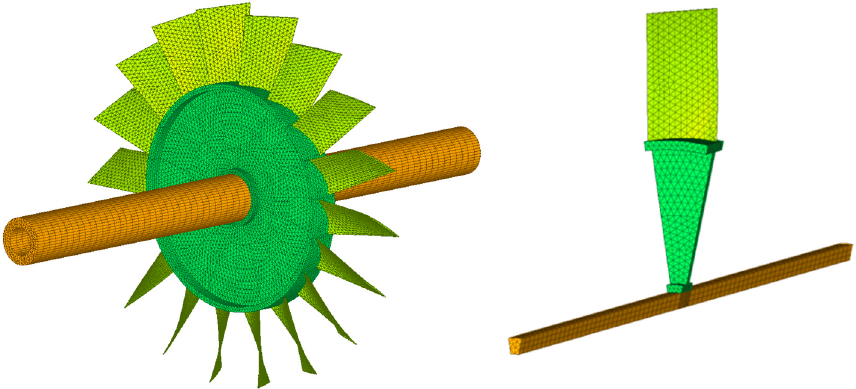
Table 1. Material properties of the blade, disc, and shaft.